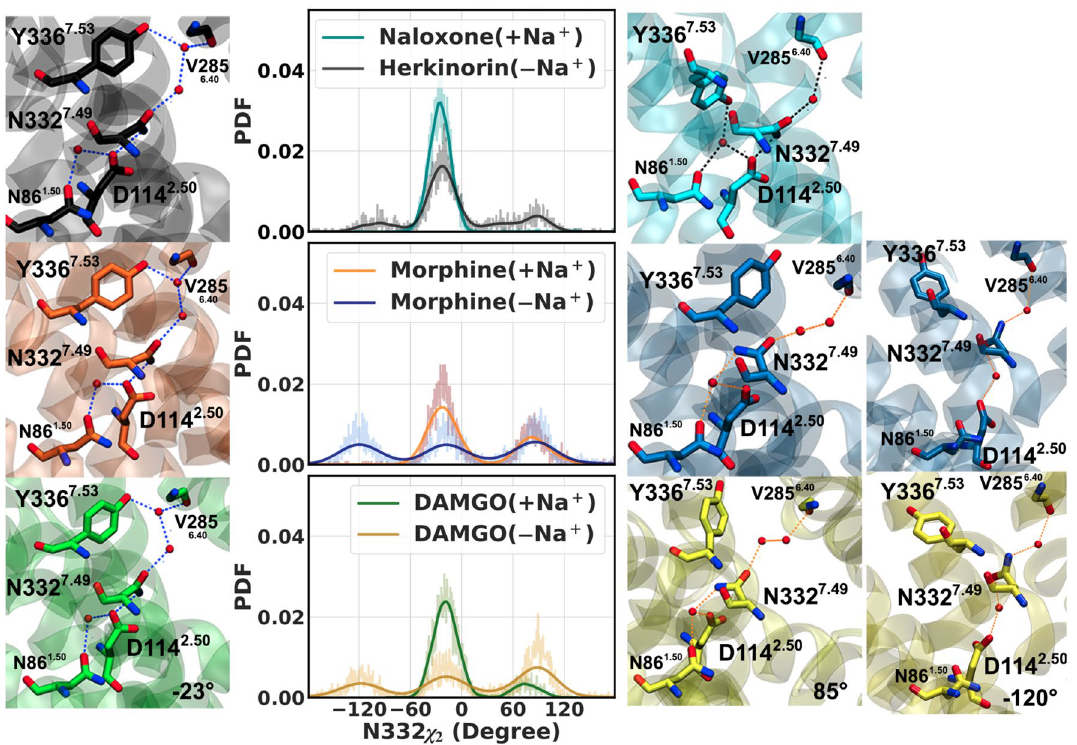
agonist and the presence of the allosteric sodium ion. The proba- bility distribution function (PDF) was calculated from three simula- tions of 500 ns